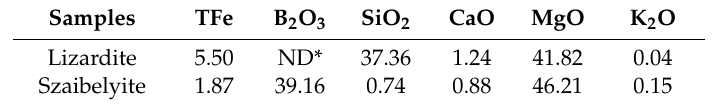
Table 1. Main chemical composition of as-prepared lizardite and szaibelyite (wt.%).